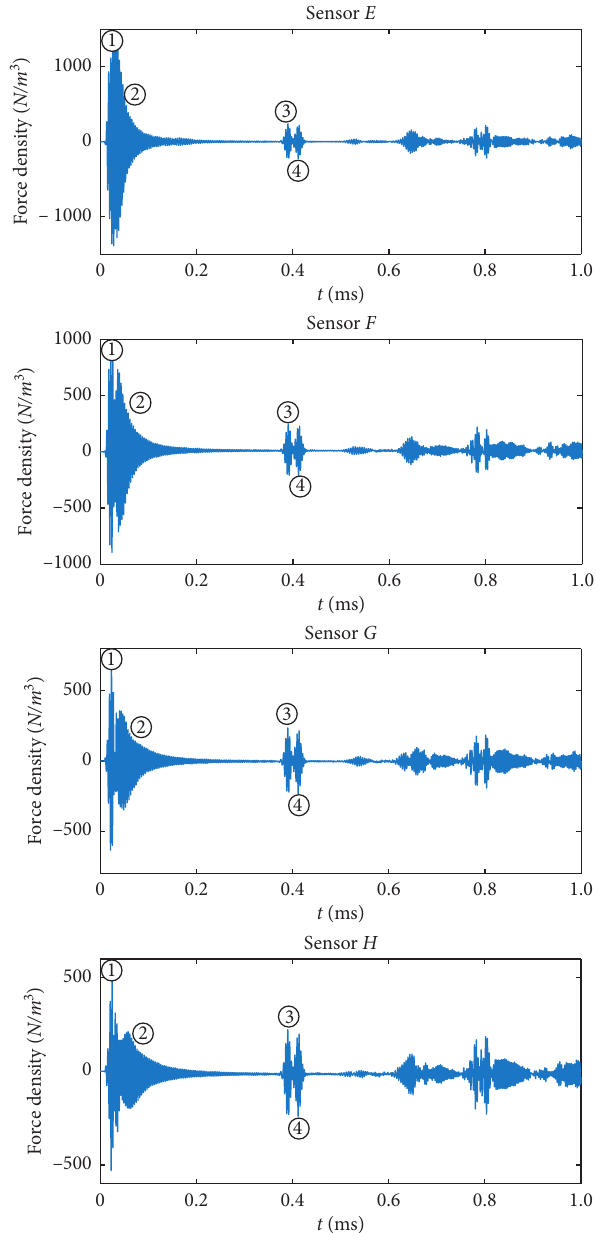
Figure 3: Sensor signal on the steel plate by numerical